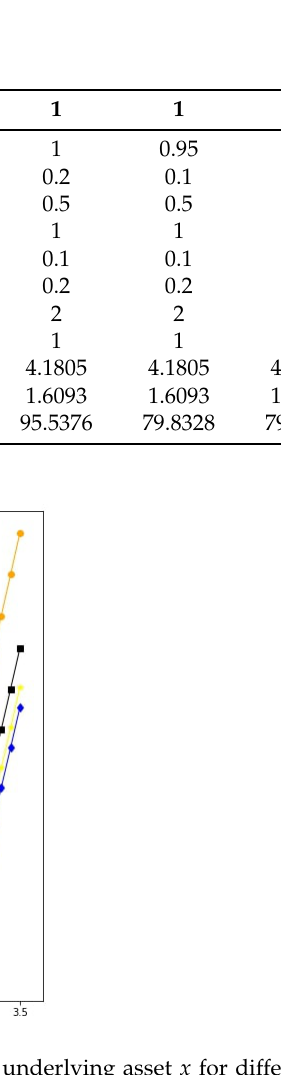
Figure 9. Option prices v ( t , x , y ) with respect to underlying asset x for different α values : v for y = 1.6093 and ρ = 0.65.